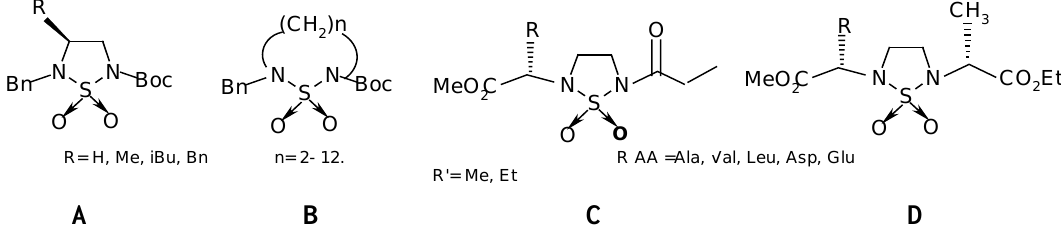
Figure 1 . Cyclosulfamide